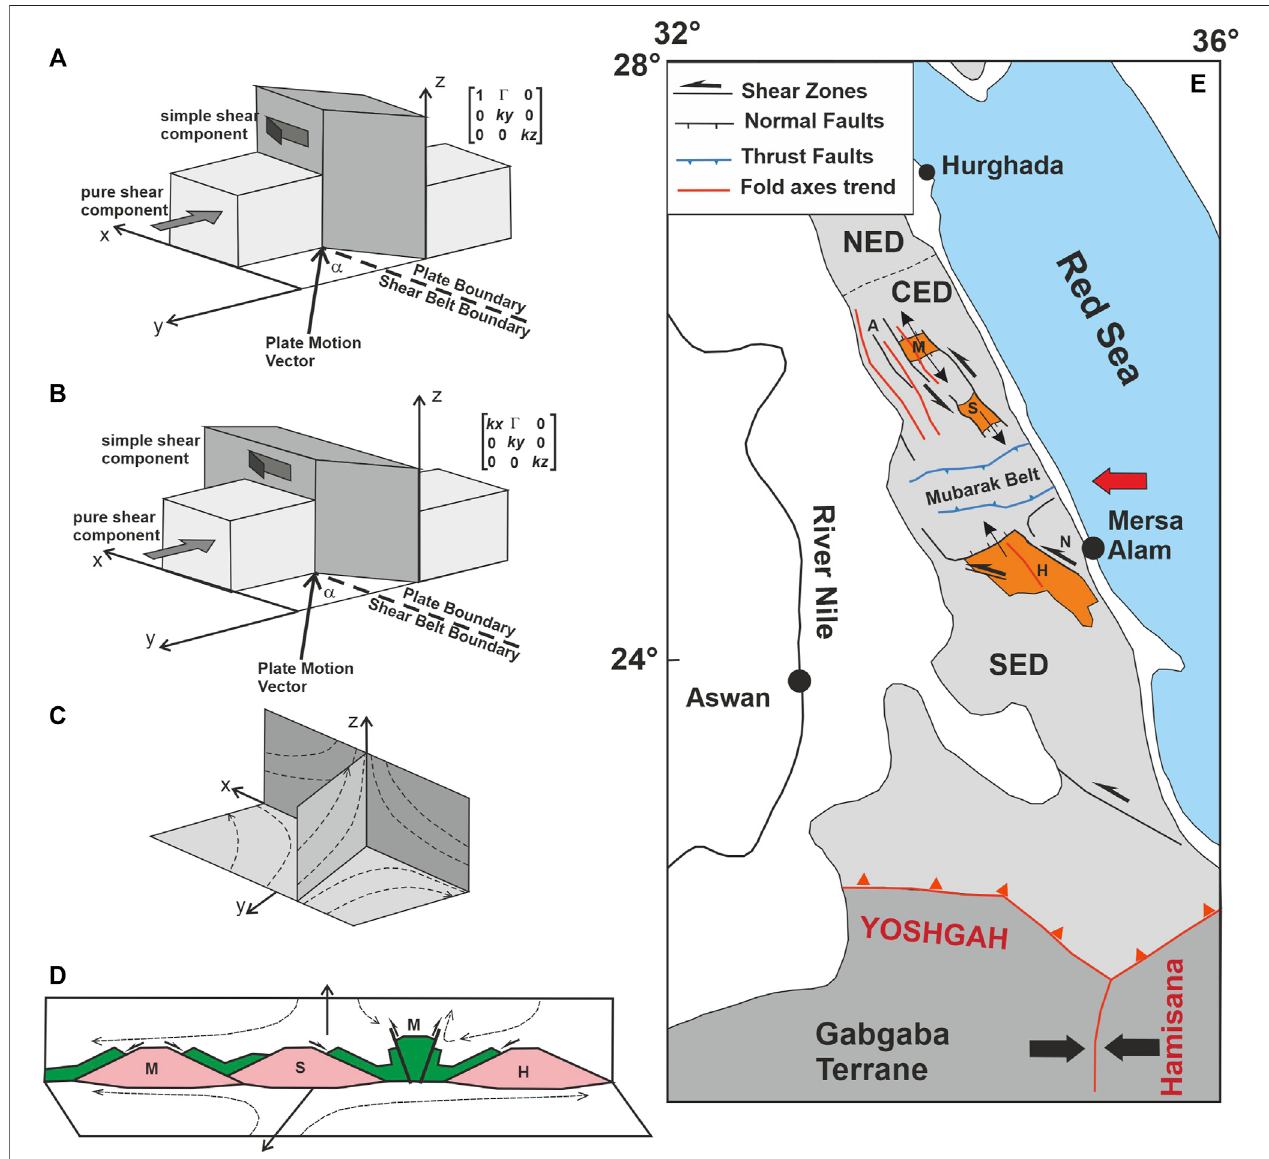
FIGURE14| ThewrenchdomainintheCEDasaresultofthesecondfar- fi eldboundarycondition.Schematiccrustalblocks,platemotionvectors,andrelated fl ow fi elds along principal sections of fl oware shown in (A – C) . Also shown are displacement gradient tensor for transpression (A) and combinedtranspression and extrusion (B,C) .FromthestructuralinventorypresentintheCED,namelyshearbeltswithsigni fi cantN-Sextensionweargueforacombinedtranspression/extrusionscenario.N-S extension within the shear belt enabled the exhumation of metamorphic domes (M: Meatiq; S: Sibai; (H): Hafa fi t) and local convergent structures as given in the sketch (D) (M: Mubarak Belt). A summary of the CED structural association is given in (E) .